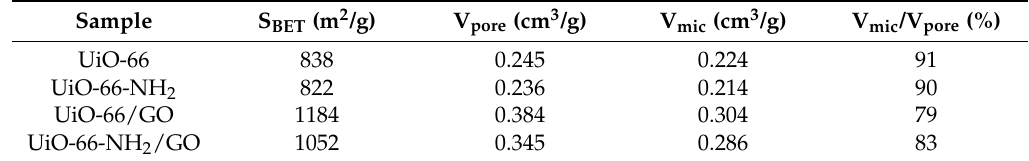
Figure 4. Pore size distribution of the different samples. Table 1. Data of porous structure of the different